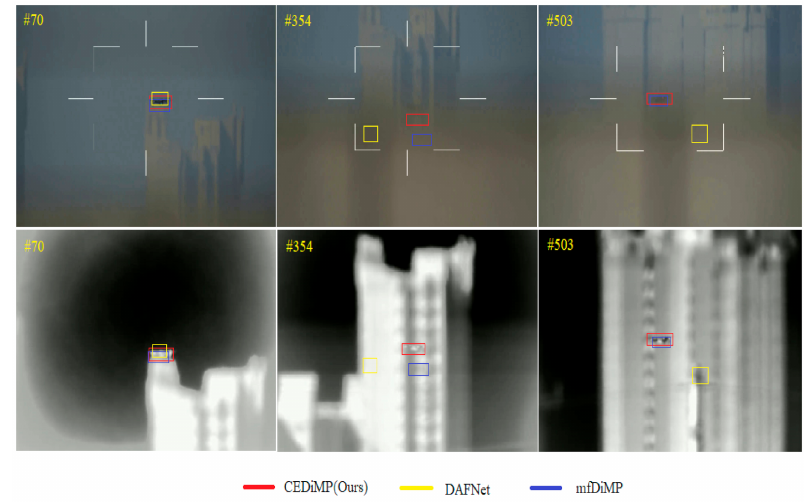
Figure 12. Qualitative comparison results of RGB and TIR modalities.